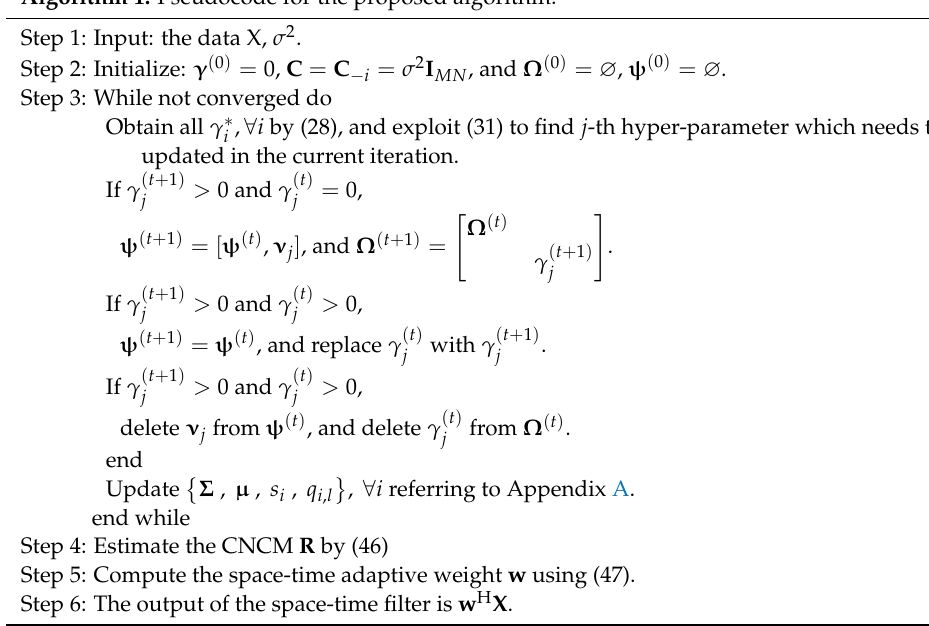
Algorithm 1. Pseudocode for the proposed